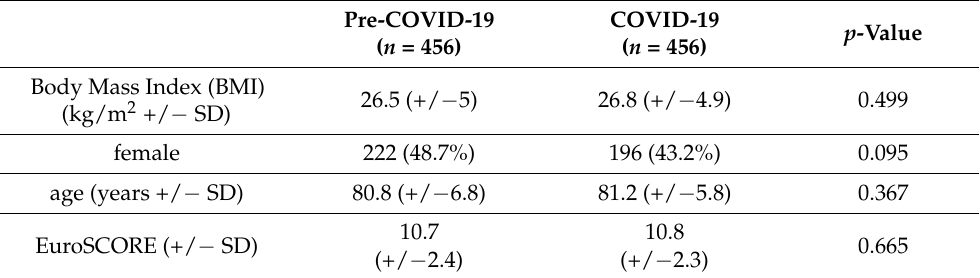
Table 2. Baseline parameters.